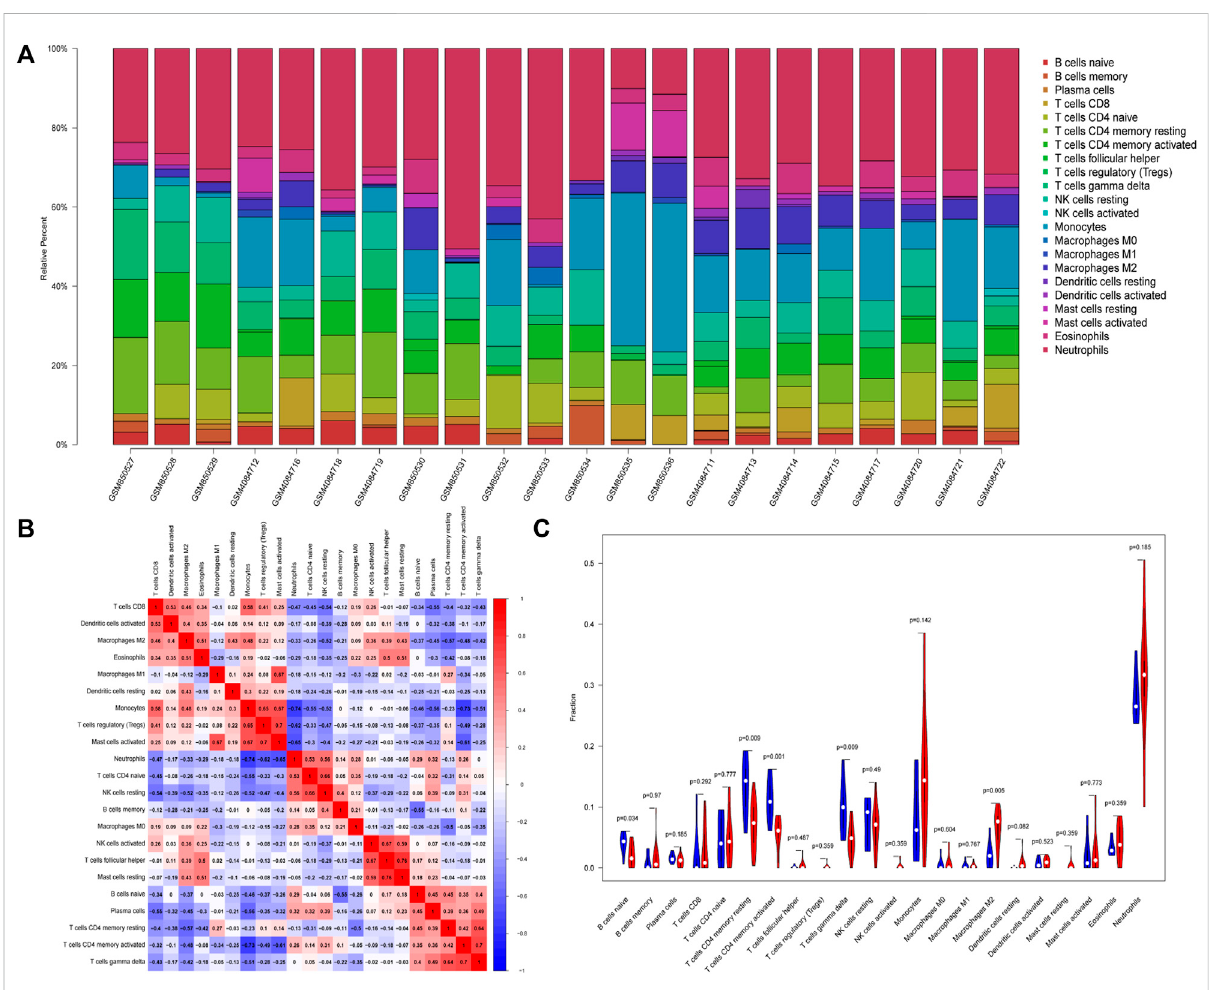
FIGURE 4 Differential distributionsofimmunecells inPCOSandnormal samples. (A) Barplotoffractionsof22immune cells. (B) Heatmapofcorrelations between 22 types of in fi ltrated immune cells in PCOS and normal samples. (C) Violin plot depicted the different in fi ltrated immune cells between PCOS and normal